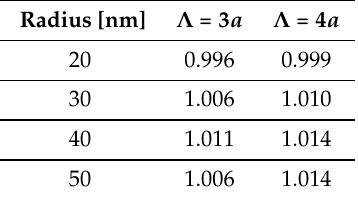
Table 4. The photocurrent enhancement for the model of MNP array on Si substrate. The radius of MNPs was taken, a = 20, 30, 40, 50, 60 nm and the array periods, Λ = 3 a ,4 a . The listed results are obtained in the model using the semiconductor dielectric function measured in bulk [42] and the dielectric function of metal without the proper plasmon damping. The solar spectrum AM1.5G. Radius [nm] Λ = 3 a Λ = 4